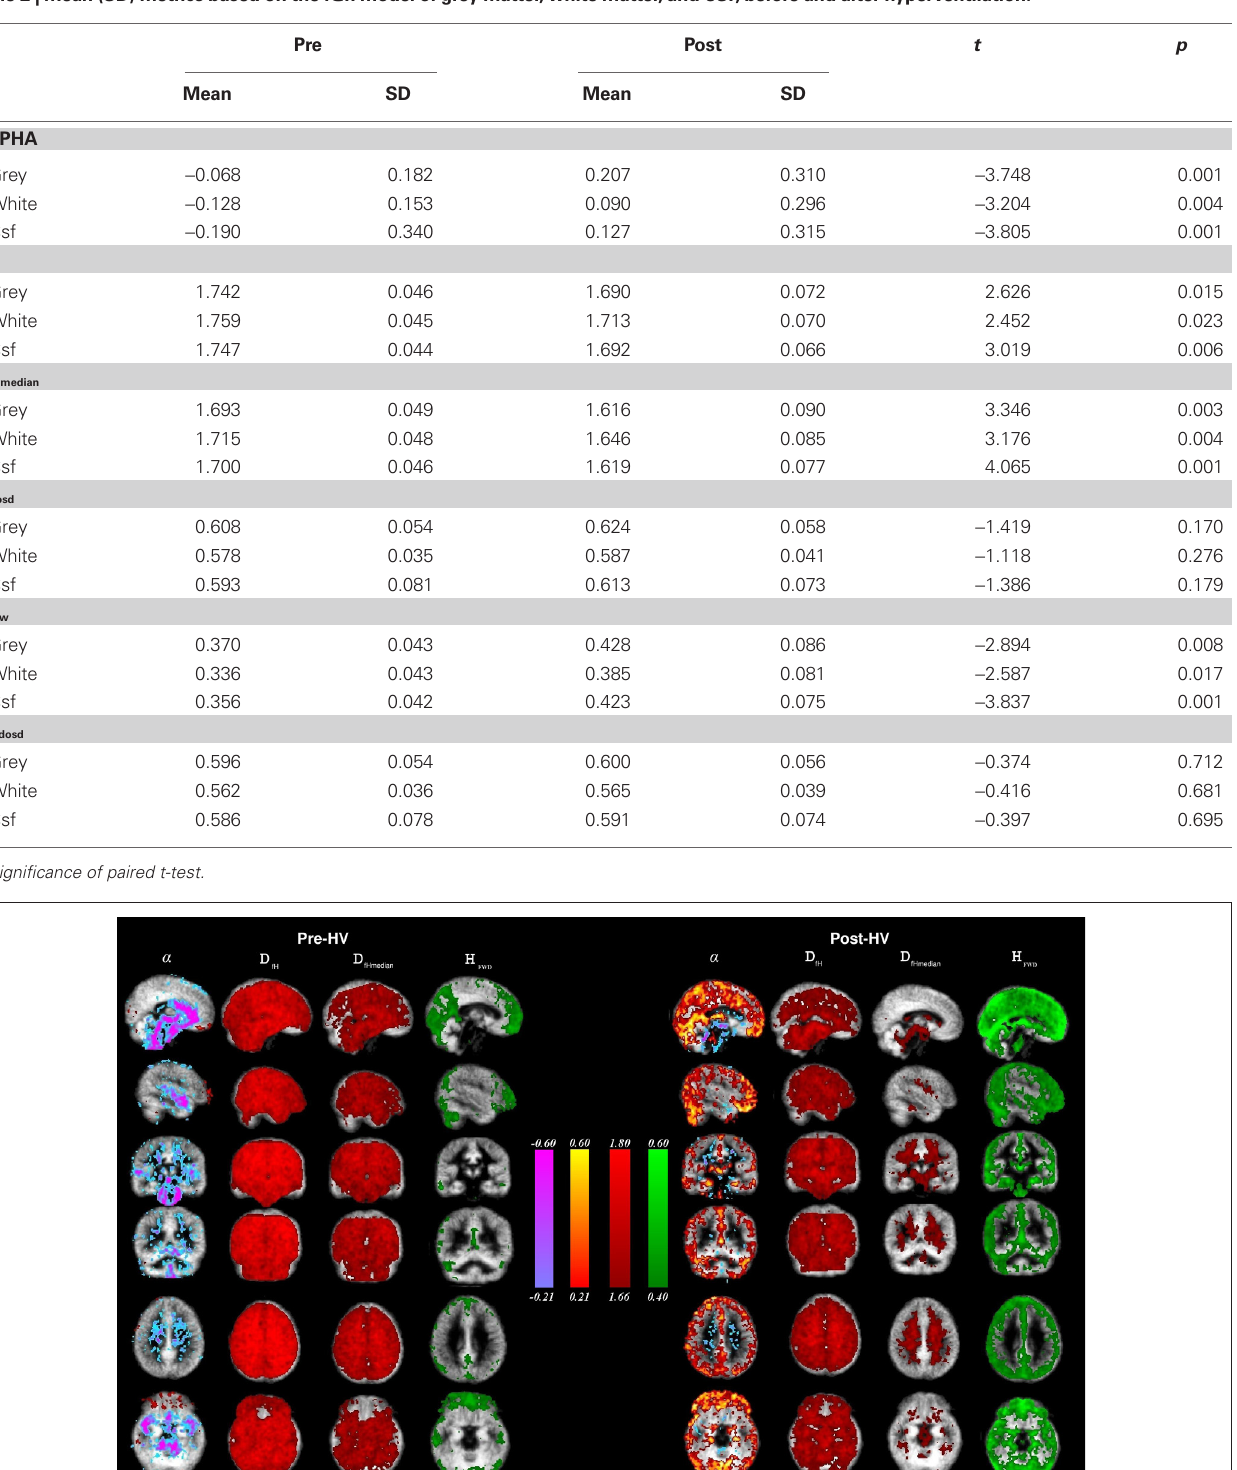
FIGURE 3 | Group mean images α (hot-cold), D and after hyperventilation ( Post-HV , on the right) were overlaid on an MNI-coordinated grey matter template image. The range of color-encoding of each metric is shown in the middle of the image.